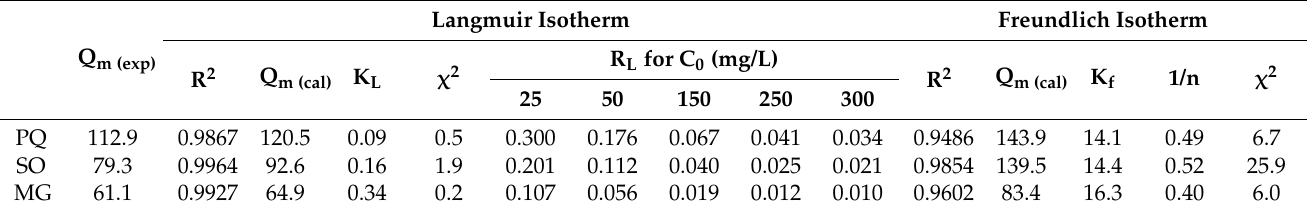
Figure 11. ( a ) Langmuir isotherm; ( b ) Freundlich isotherm of contaminant adsorption (conditions: 2 g/L of adsorbent dosage, 180 minutes of contact time, optimal pH, and temperature at 303 K). Isotherm parameters were calculated and described in Table 3. The correlation coeffi- cient (R 2 ) was essentially superior for the Langmuir isotherm model (R 2 = 0.9867, 0.9964, and 0.9927) than the Freundlich isotherm model (R 2 = 0.9486, 0.9854, and 0.9602) for PQ, SO, and MG adsorption, respectively. Langmuir isotherm model displayed a correlation coefficient close to 1 which informed a linear relationship, confirmed the suitability of the model with experimental data, and explained the monolayer adsorption for contaminants on the regular surface of nanosponges. The Chi-square values for the Langmuir model (0.5, 1.9, and 0.2) were lower than the Freundlich isotherm model (6.7, 25.9, and 6.9) for PQ, SO, and MG adsorption, respectively. The small Chi-square values inferred that the experimental data were appropriate with the Langmuir isotherm. Finally, the separation factor (R L ) was reduced with the rise of initial concentrations for all contaminants, which displayed a strong affinity between nanosponges and contaminants if 0 < R L < 1. Table 3. Langmuir and Freundlich isotherm parameters (conditions: 2 g/L of adsorbent dosage, 180 minutes of contact time, pH of 6.5 and temperature at 303 K). Langmuir Isotherm Freundlich